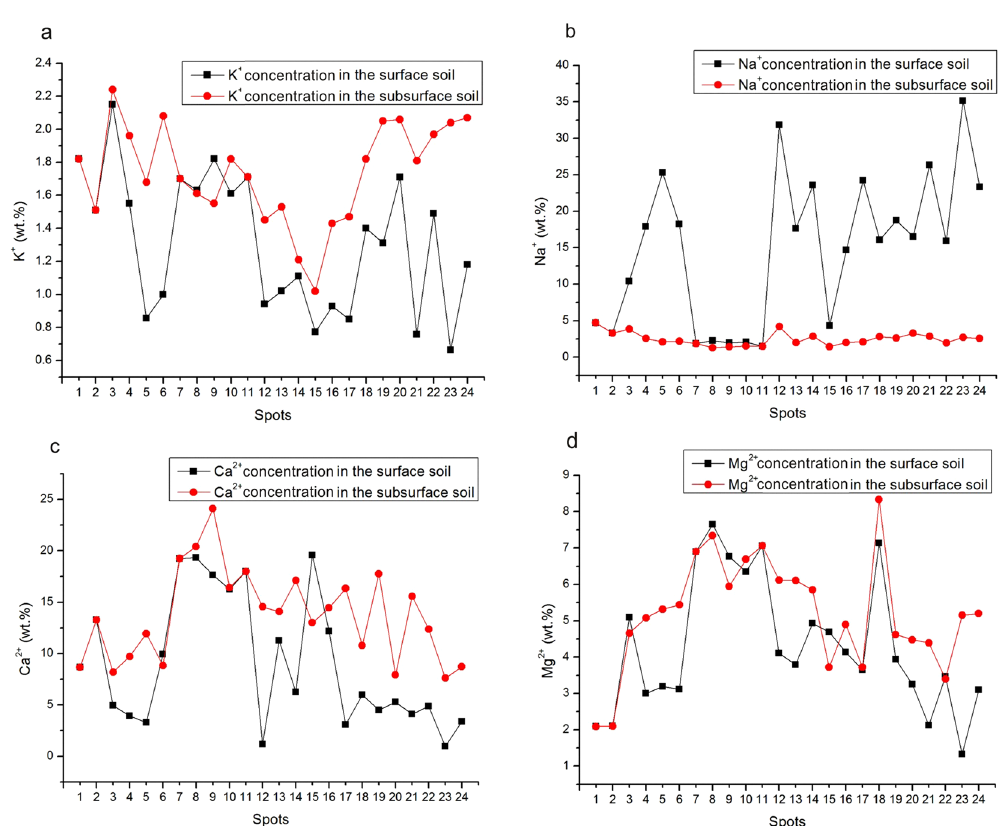
Figure 3. The distributions of the main soil cations. ( a ) K + concentration; ( b ) Na + concentration; ( c ) Ca 2 + concentration; ( d ) Mg 2 +